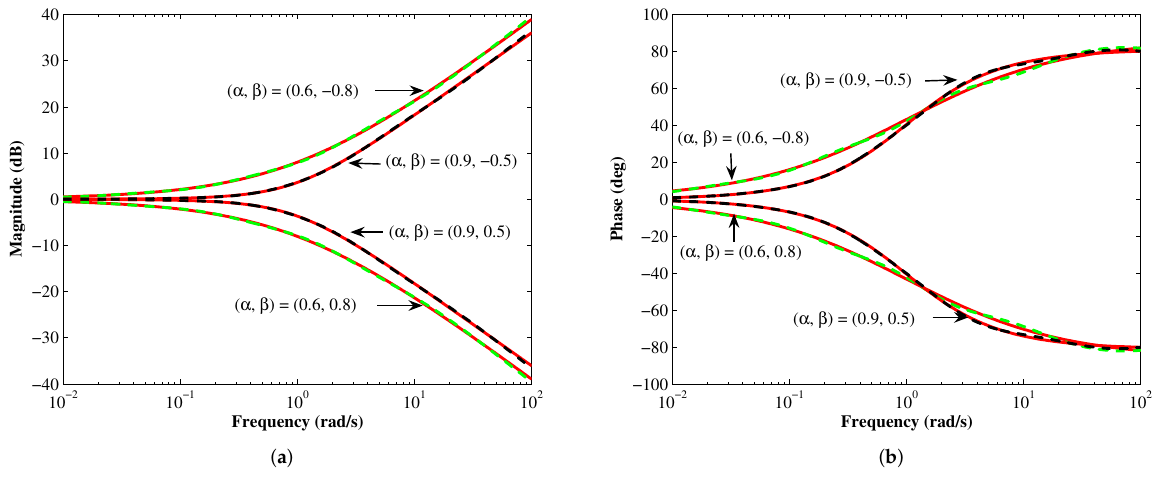
Figure 5. ( a ) Magnitude and ( b ) phase responses of the proposed FLPFs and FILPFs for N = 4. The theoretical response is shown in solid